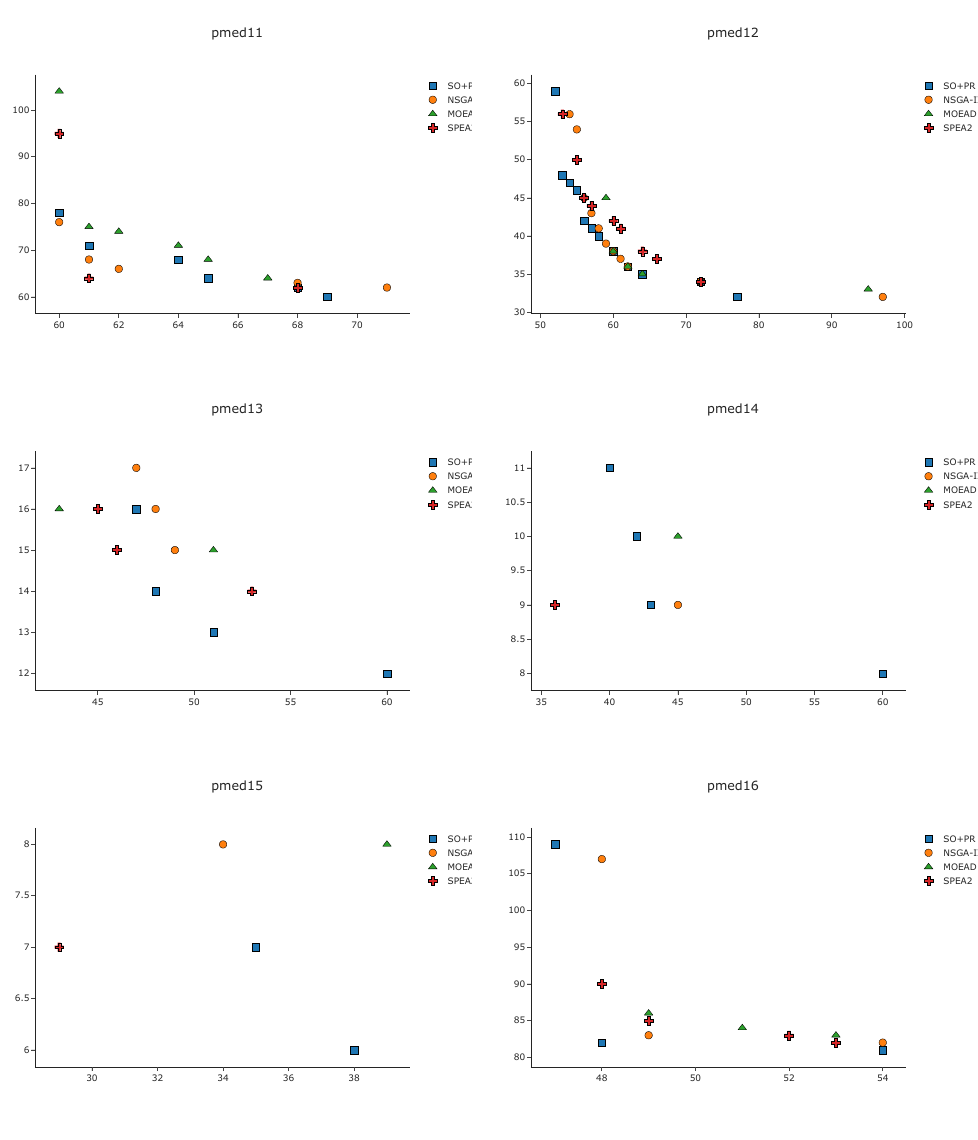
Figure A1. Efficient sets of solutions for SO+PR , MOEAD , NSGA-II , and SPEA2 for instances pmed1 to pmed10.